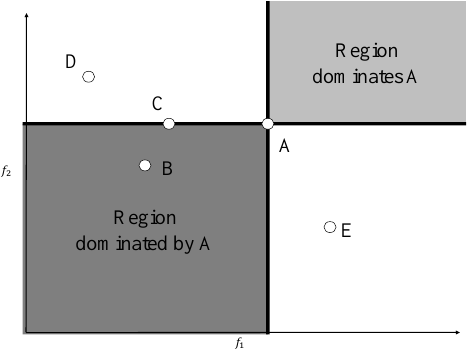
Figure 1. Dominance concept for a maximization problem where A dominates B and C; A, D, and E are